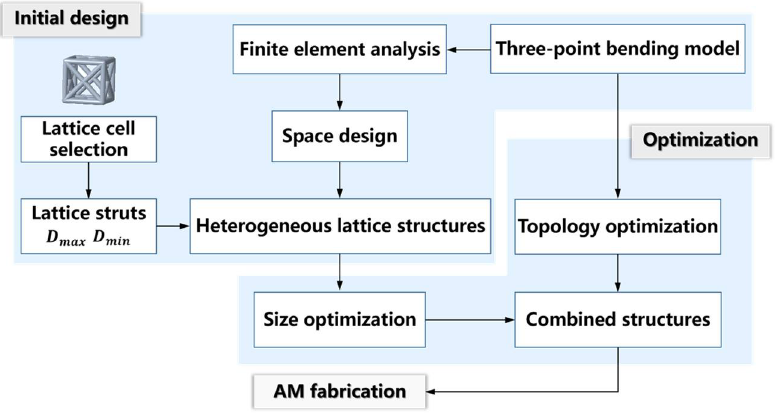
Figure 2. The design flow of heterogeneous lattice structures in this work.